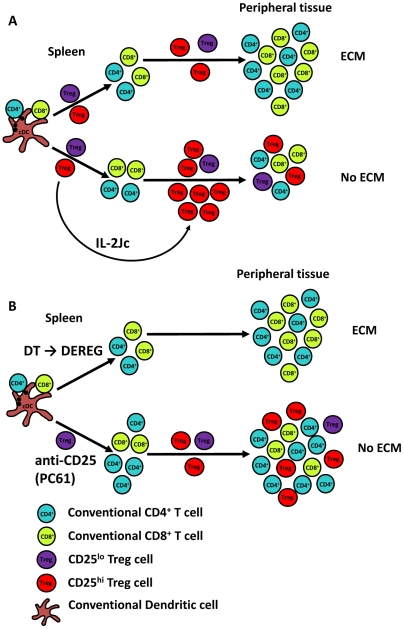
A proposed model for the roles of Treg cells in ECM.A). Following PbA infection of C57BL/6 mice, Treg cells suppress potent anti-parasitic T cells responses, but the PbA-specific T cell responses that do emerge promote parasite tissue sequestration, resulting in disease and death. However, if Treg cells can be expanded and activated sufficiently by early signalling via the high affinity IL-2 receptor, they can prevent pathogenic T cell responses mediating parasite tissue sequestration. B). The removal of CD25hi Treg cells prior to PbA infection allows the generation of a potent anti-parasitic CD4+ T cell response, but also the re-emergence of CD25hi Treg cells during the course of infection, resulting in an enhanced and qualitatively better anti-parasitic CD4+ T cells response that controls parasite growth and a mechanism to prevent parasite tissue sequestration. In contrast, if all Treg cells are depleted prior to infection, as is the case when DEREG mice are treated with DT, a balance between emerging anti-parasitic CD4+ T cell responses and expanding Treg cell responses is not achieved, and T cell-mediated immune pathology occurs. Conventional CD4+ (blue) and CD8+ (green) T cells, as well as CD25hi (red) and CD25lo or negative (purple) Treg cells are shown and disease outcome in different experimental conditions is shown.